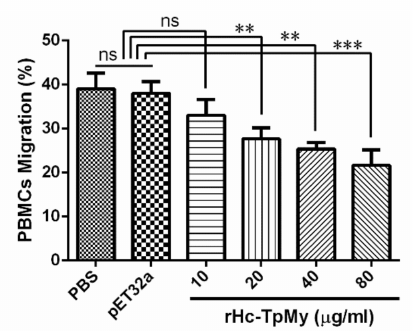
Figure 5. Inhibition e ff ects of rHc-TpMy on cell migration. PBMCs with di ff erential concentrations of rHc-TpMy protein, pET32a protein or control bu ff er (PBS) were stimulated and the random migration was determined. The di ff erence between the mean values was calculated using ANOVA. PBMCs used for all replicates of distinct treatments in each experimental repetition were derived from the same goat. The data are presented as the mean ± SD and are representative of three independent experiments (** p < 0.01, *** p < 0.001 and ns: